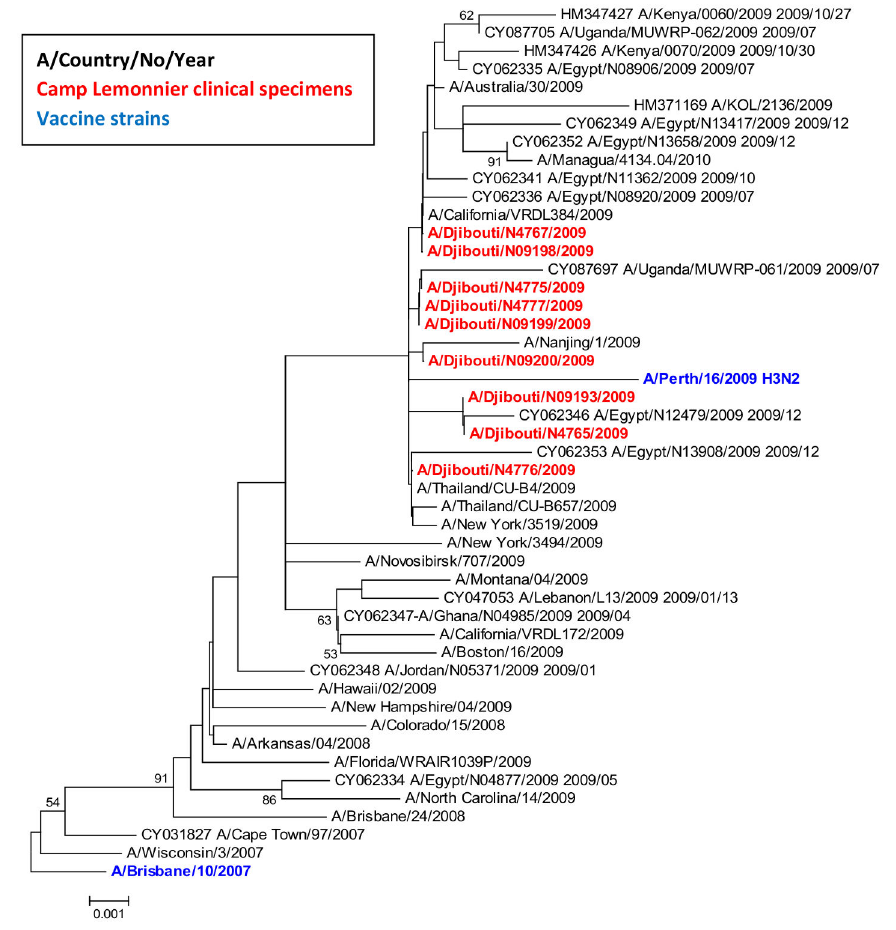
Figure 2. Phylogenetic analysis of H3N2 HA gene segments. *Phylogenetic tree of influenza A/H3N2 using the Neighbor- Joining method and Bootstrap test (1000 replicates). The evolutionary distances were computed using the Maximum Composite Likelihood method. The phylogenetic tree was generated using MEGA4 software. Phylogenetic analysis rooted to the 2009 influenza vaccine strain